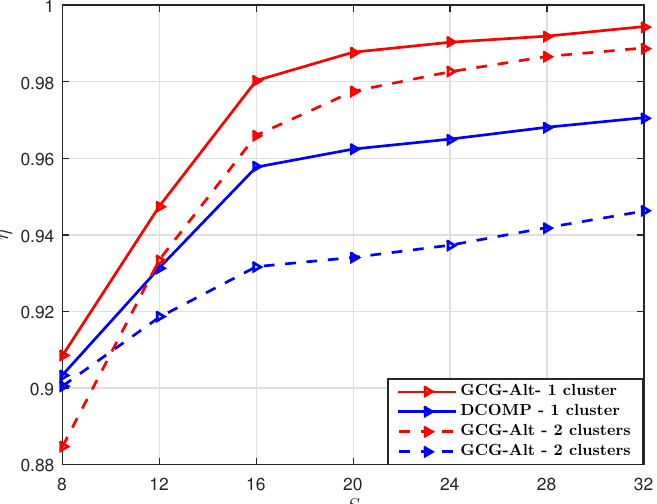
Figure 8. Comparison of η of the GCG-Alt estimator and the DCOMP estimator under the USPA system, where N t = 64, N r = 16,PNR = 10 dB, and T =